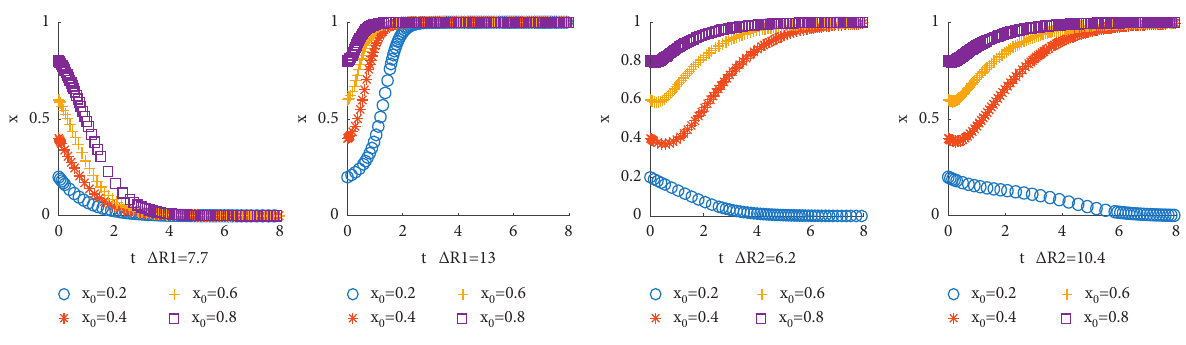
Figure 5: The impact of BIM incremental revenue on evolution system.